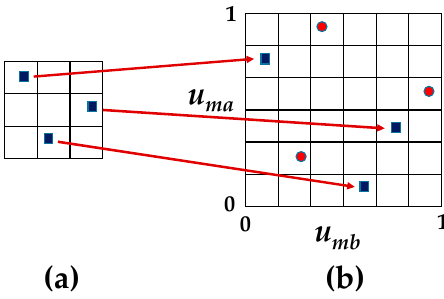
Figure 4. Mapping the new sample points in unrepresented space. ( a ): The samples generated in the unrepresented variable space; ( b ): Six samples in uniform distributions.